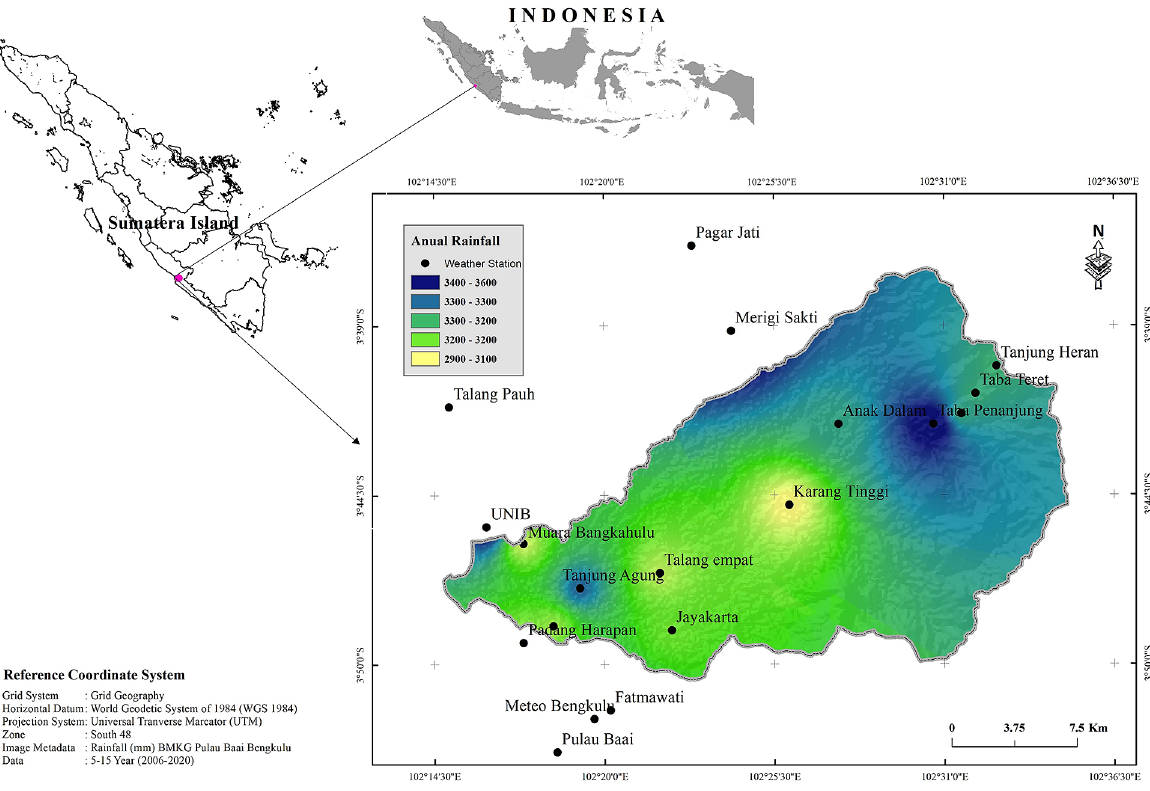
Fig. 1. Spatial distribution of mean annual rainfall and stations used for calculating the rainfall erosivity and the erosivity density (ED) in Air Bengkulu